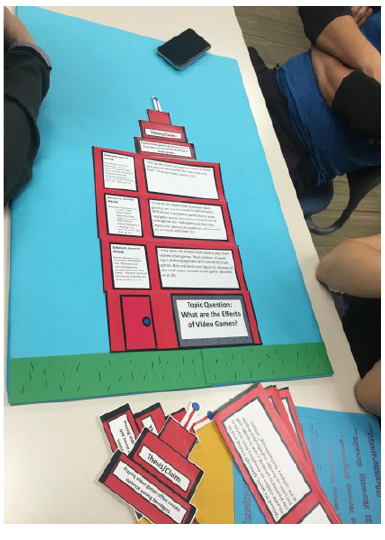
Sample Argument Architect game with board, pieces, and instructions.